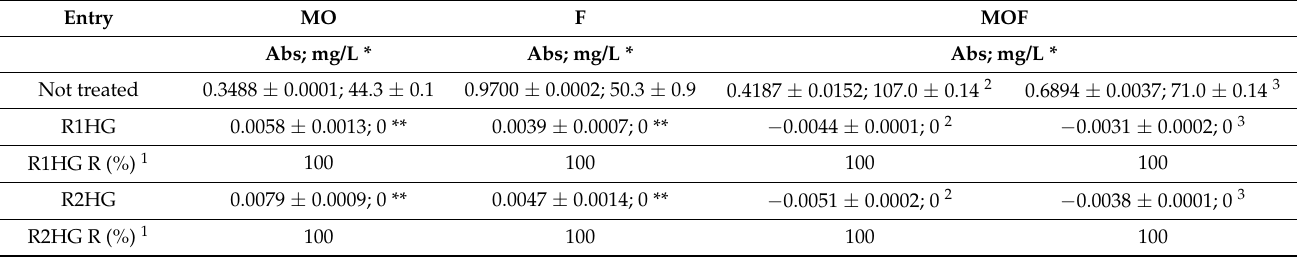
Table 7. Results from absorption experiments in column upon